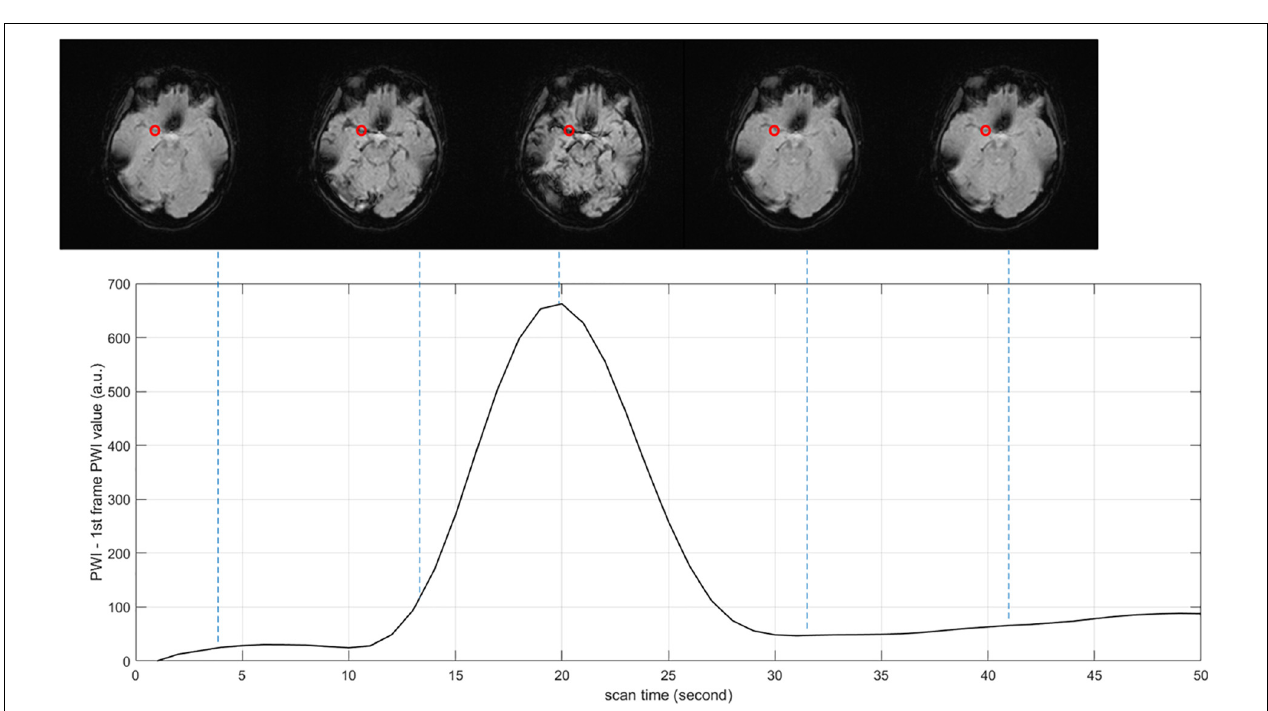
FIGURE 4 | Arterial input function (AIF) curve extracted from time series. The red point shows the location where AIF is extracted, the value of PWI decreases first and then increases with time.